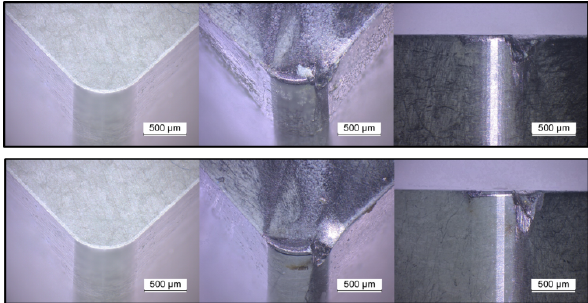
Figure 9: Stability lobes considering tool